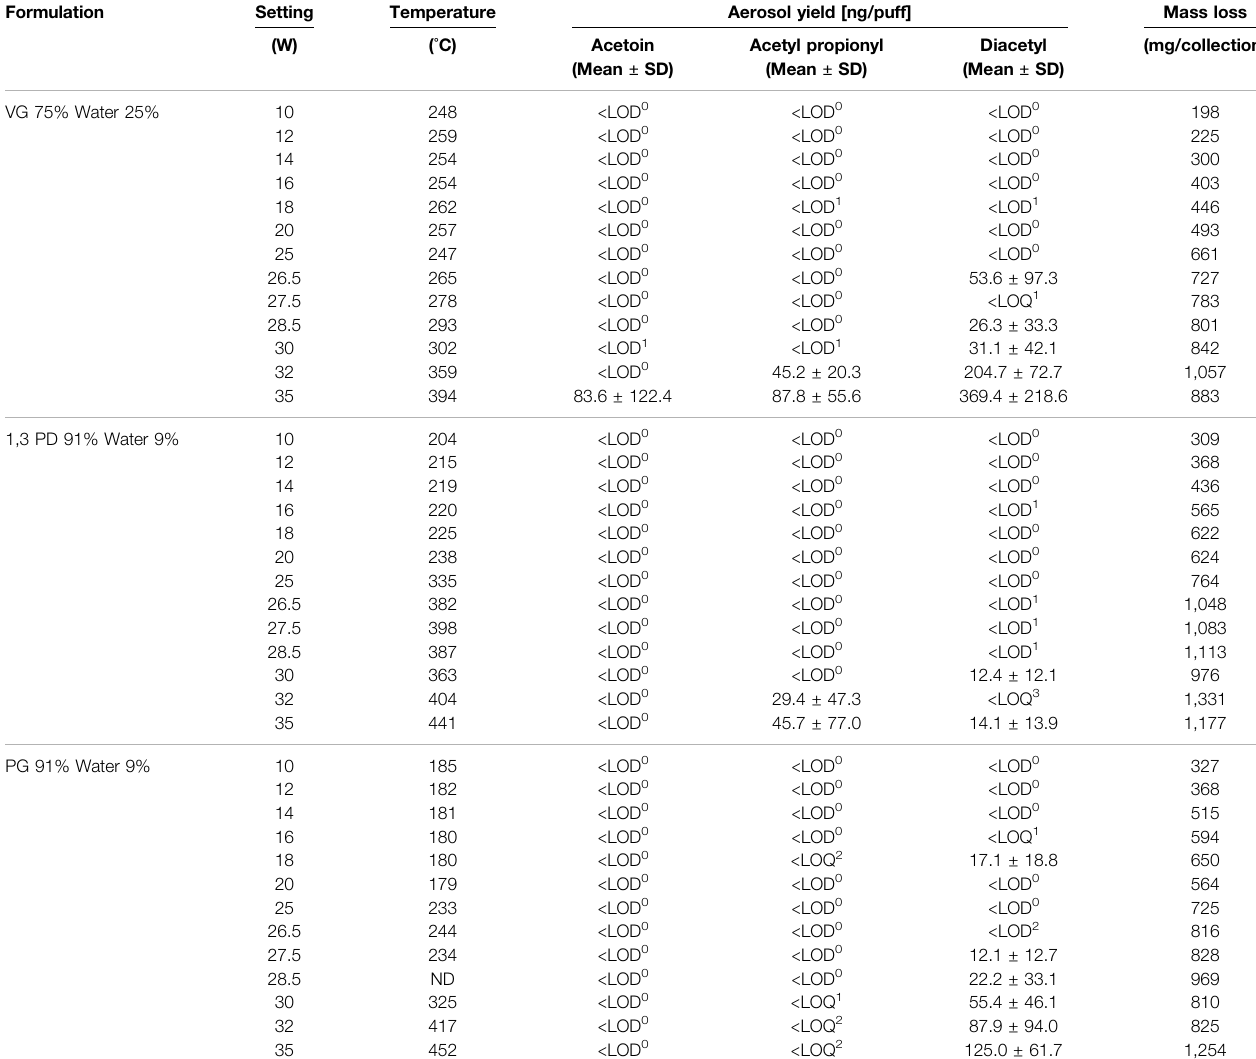
TABLE 4 | Effect of power setting on aerosol yields of acetoin, acetyl propionyl and diacetyl from e-cigarettes with e-liquids consisting of mixtures of humectants and water. Formulation Setting